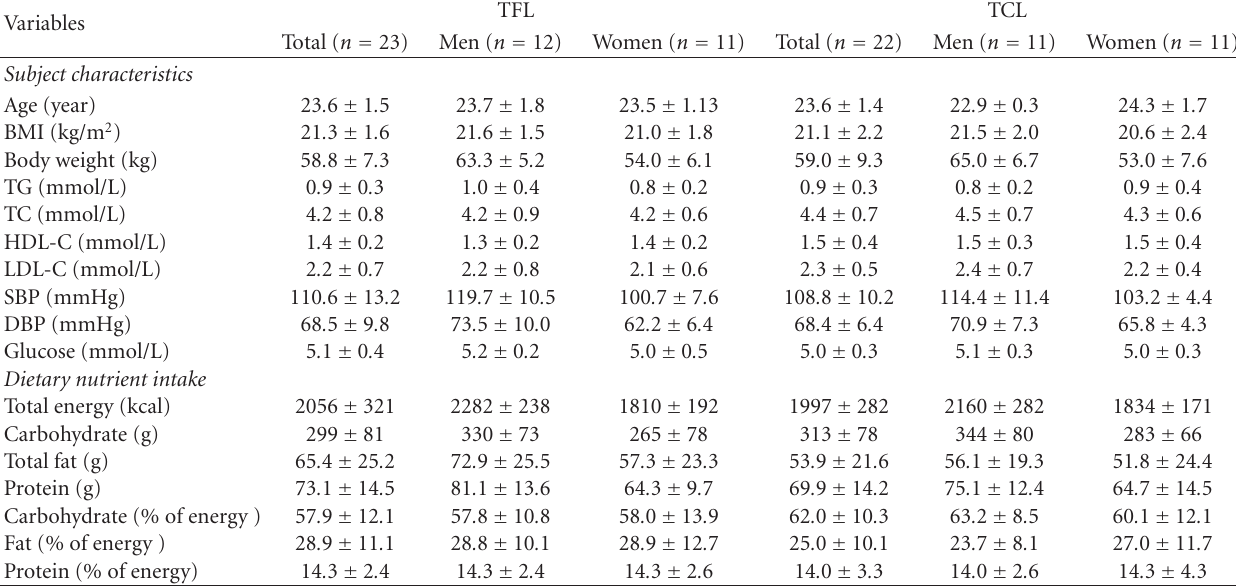
Table 1: Baseline characteristics and dietary nutrient intake of subjects included in TFL and TCL groups.